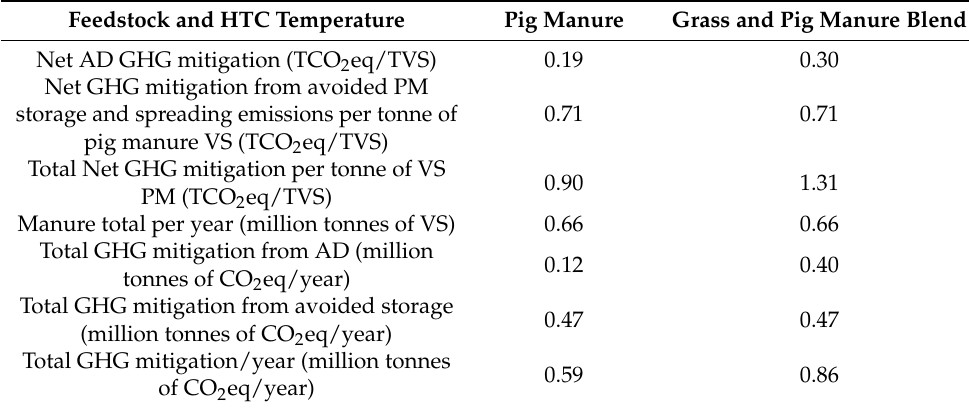
Table 3. UK GHG mitigation from AD of PM and PM-grass